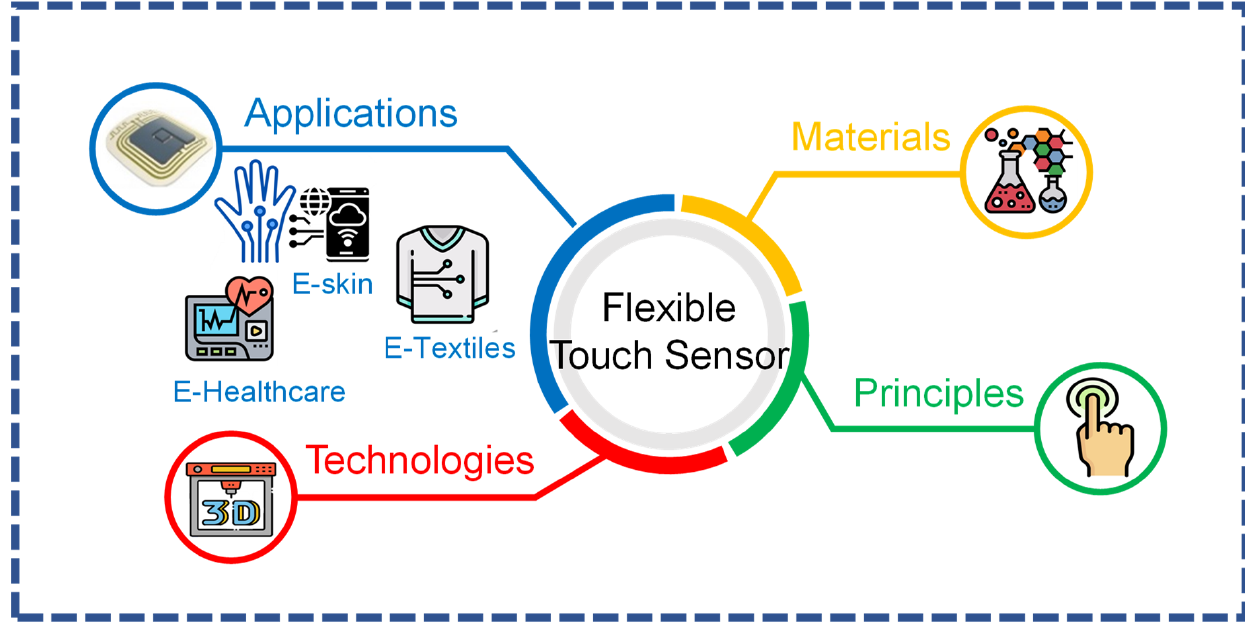
Figure 2. Overview of flexible touch sensors.